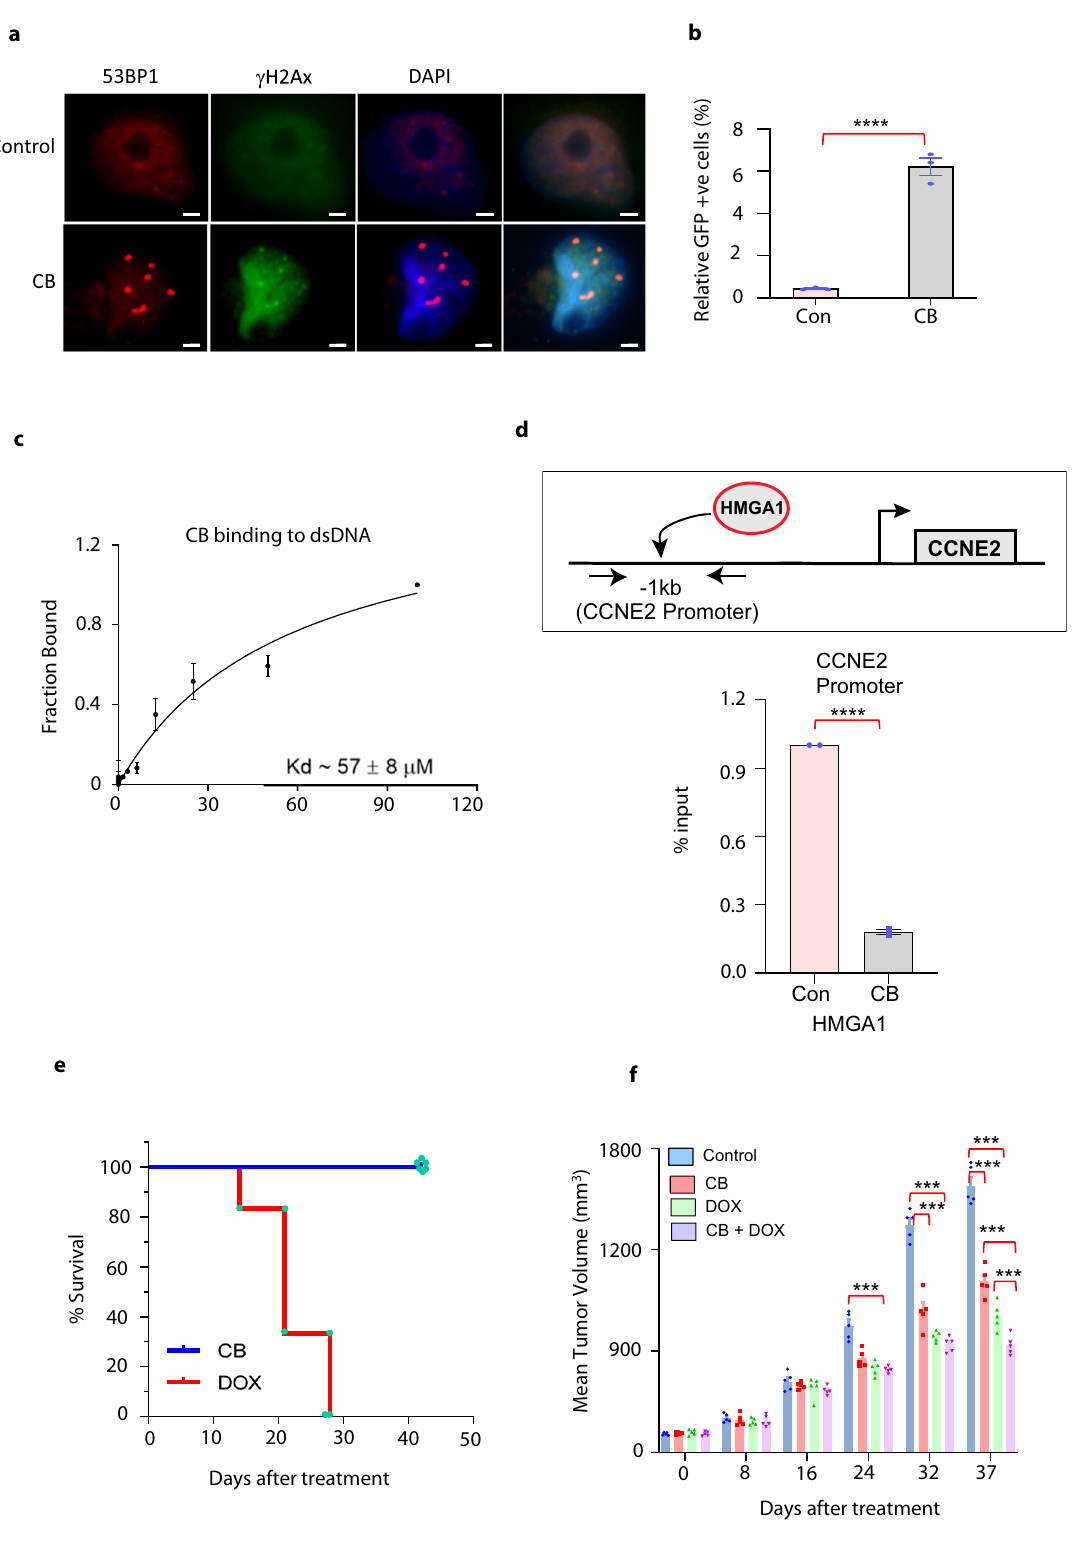
anti-53BP1 antibody (1:200 dilution; Bethyl Laboratories) and Phospho γ -H2AX (1:200 dilution; Ab2893) overnight followed by incubation with TRITC-conjugated goat anti-rabbit secondary antibody (1:500). The cells were counterstained with DAPI and observed under a fl uorescence microscope 15, 40 . Homologous recombination, non-homologous end-joining (NHEJ), and alter- native non-homologous end-joining (Alt-NHEJ) assays . The I-SceI-based DR-